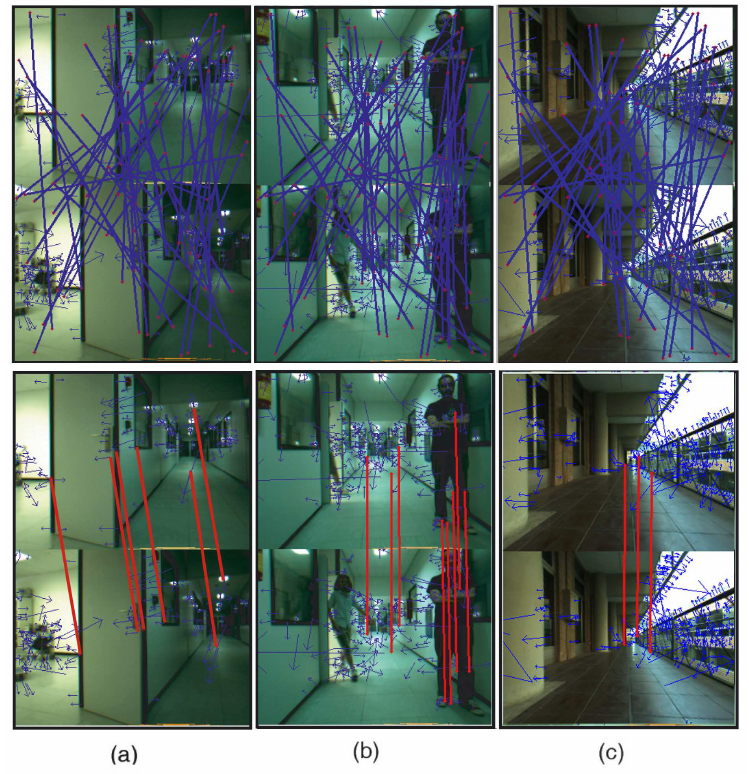
Figure 9. Illustrative examples of the matching algorithm proposed in our visual odometry system for three different image tests used in the comparative study (results of the matching process for the images of the Figure 7 (a–c) , respectively). On the top, the initial matching which includes the 80 % of outliers is shown. Below, results of the matching algorithm used in our approach have been